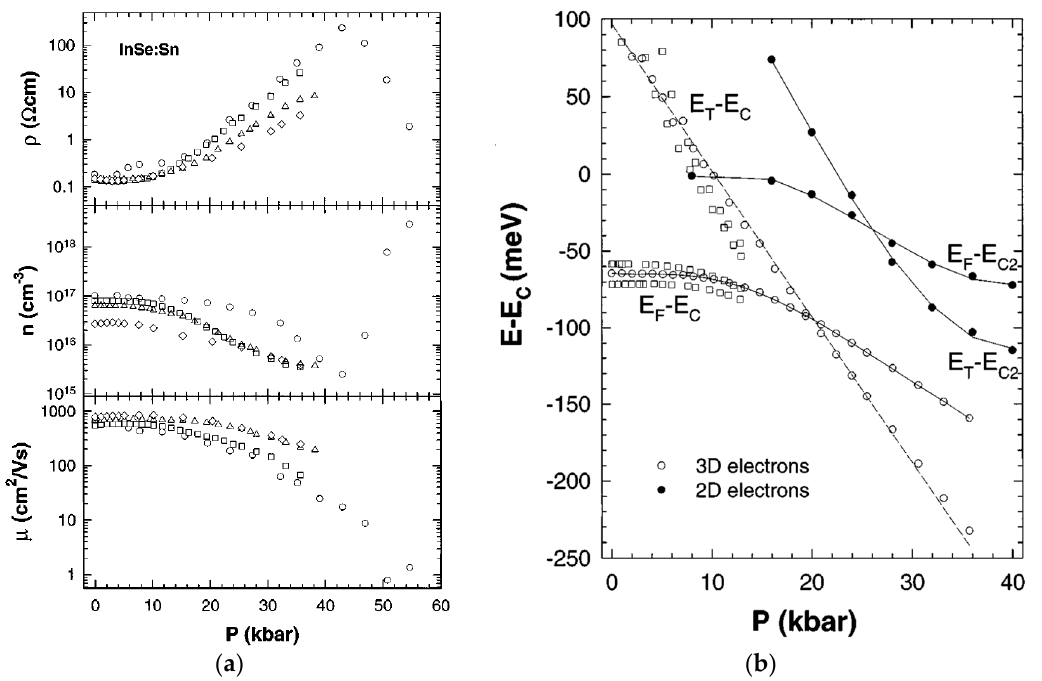
Figure 20. ( a ) Pressure dependence of the transport parameters (resistivity, electron concentration, and electron mobility) in Sn-doped n-type γ -InSe. ( b ) Pressure dependence of the Fermi level and the deep trap (both with respect to the conduction band minimum) as determined from the data in Figure 20a